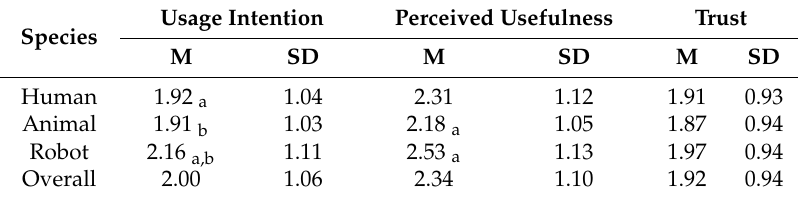
Table 10. Participant’s usage intention, perceived usefulness, and trust ratings for all agent